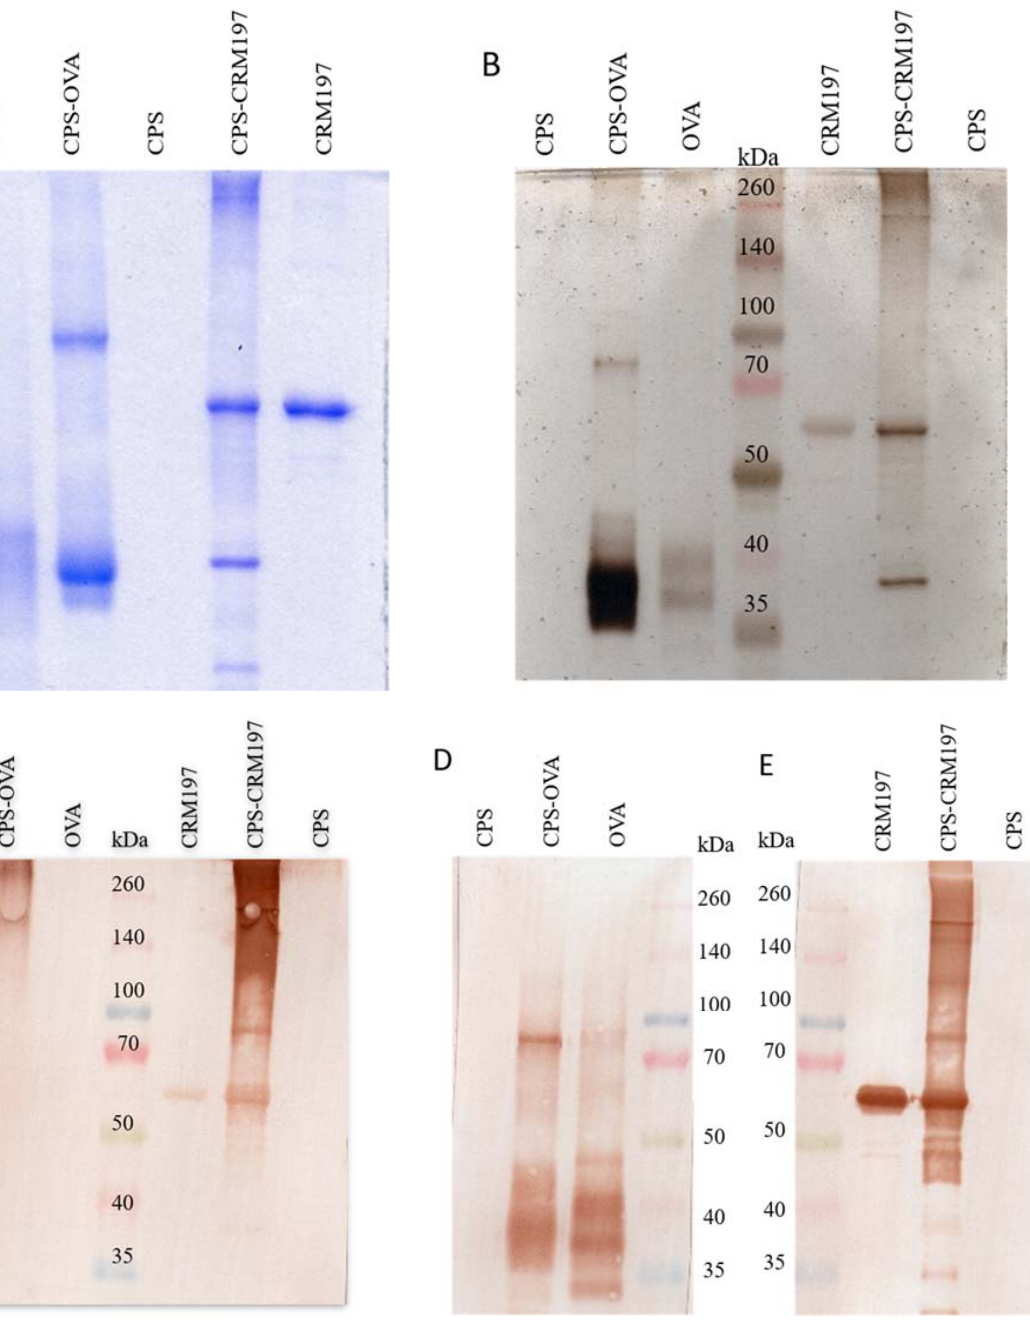
Figure 1. Confirmation of CPS conjugation to carrier proteins. Presence of new bands documents conjugation of CPS having various molecular weight to carrier proteins. Coomassie brilliant blue staining, silver staining and western blot; 12.5% acrylamide gels were stained after SDS ‐ PAGE with Coomassie Brilliant Blue R ‐ 250 Dye ( A ), or stained with silver ( B ), or samples were transferred after SDS ‐ PAGE to PVDF membrane and developed with anti ‐ S. suis serotype 2 rabbit serum ( C ), anti ‐ chicken egg albumin (ovalbumin) monoclonal antibody ( D ) or anti ‐ Diphtheria toxin A subunit monoclonal antibody [8A4] ( E ). For SDS ‐ PAGE, the marker Spectra Multicolor Broad Range Protein Ladder (Thermo Scientific) was used.